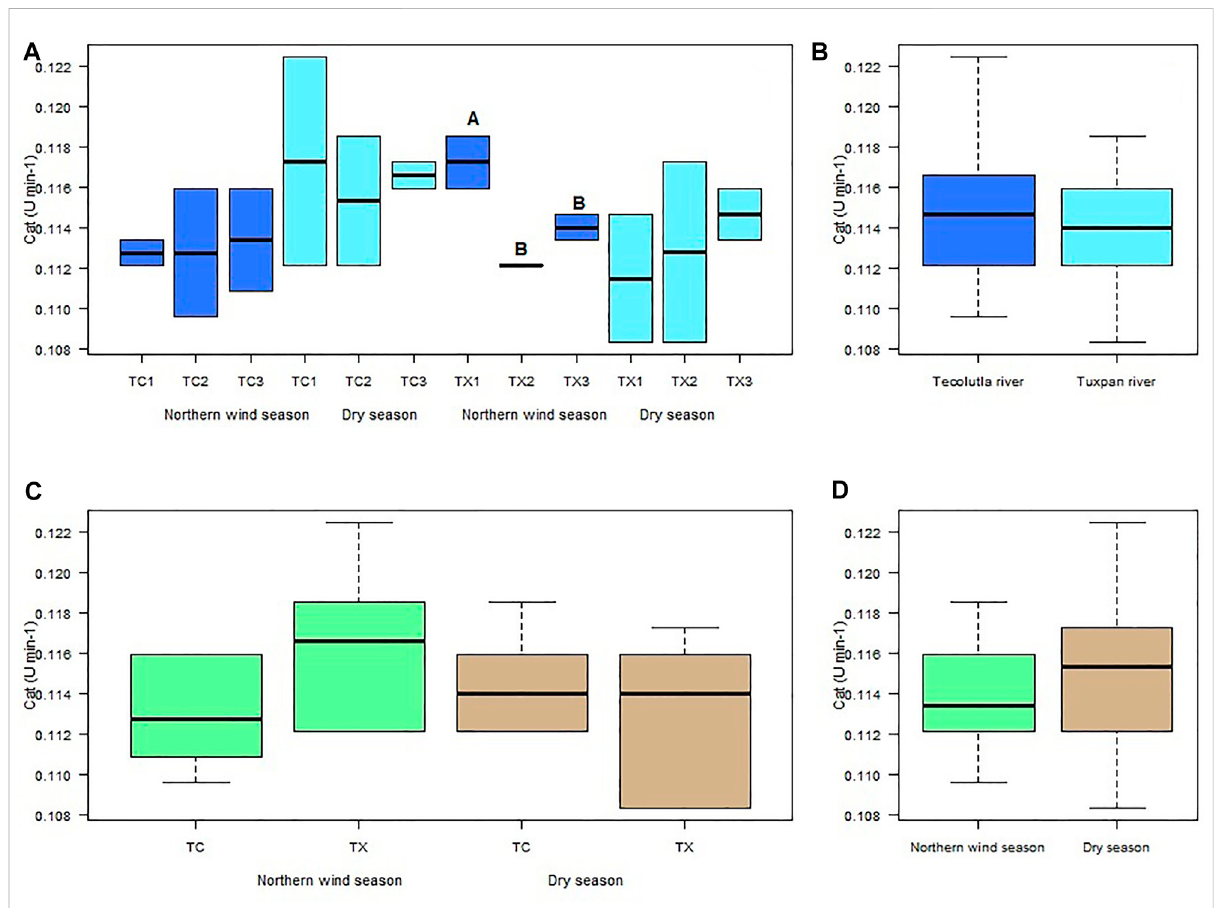
BoxplotsforCATactivityin Physellaacuta . (A) CATactivitybystudysiteandseason; (B) CATactivitybyriver; (C) CATactivitybyriverandseason; and (D) CAT activity by season. N = 24 by study site, n = 72 by season, and n = 144 by river (A ≠